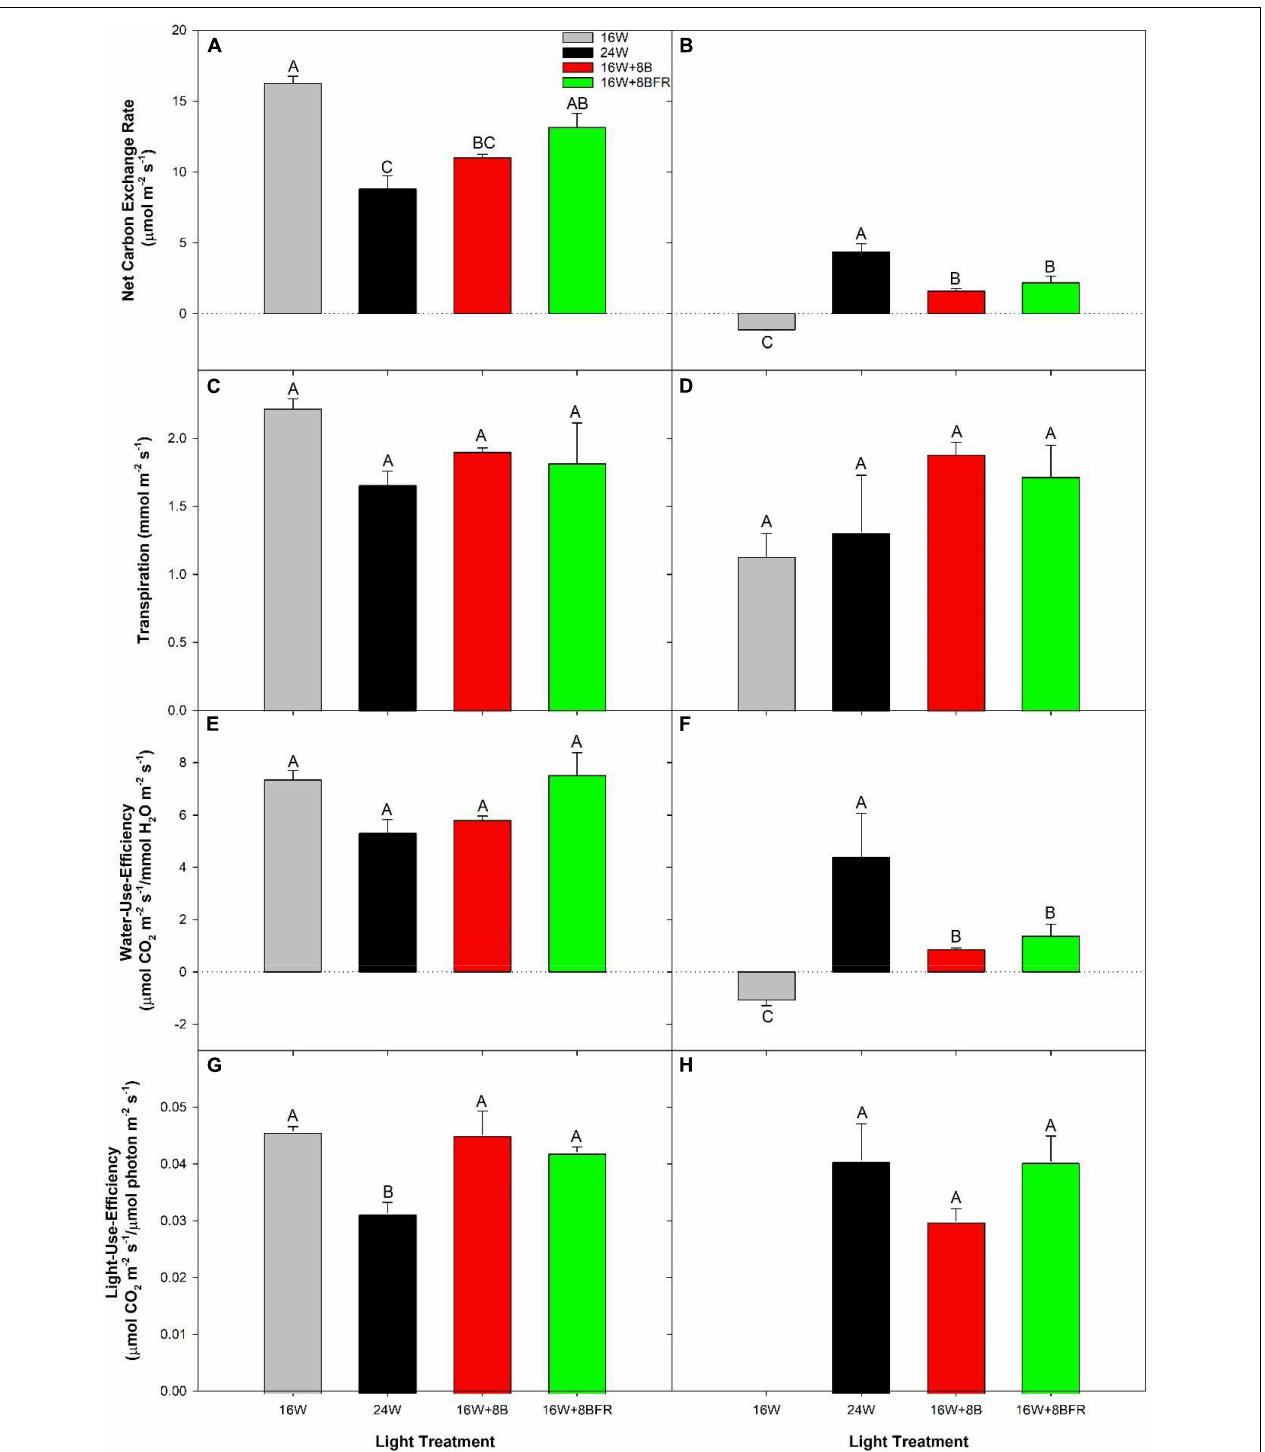
FIGURE 3 | Net carbon exchange rates (A,B) , transpiration rates (C,D) , water-use-efficiency (WUE; E,F ), and light-use-efficiency (LUE; G,H ) of the fifth leaf from pepper plants grown under the lighting treatments at 99 DIT during the daytime (A,C,E,G) and nighttime (B,D,F,H) . Daytime measurements were performed using a Li-COR 6400 fitted with a clear top chamber on a cloudy day and thus represent the photosynthesis driven mostly by the supplemental lighting. Nighttime measurements were performed after 22:30 (half an hour after night lighting started), allowing leaves to adjust to the new light environmental conditions. Error bars represent the standard errors of the means of n = 4. Letter groups (A, B, C) represent a significant difference within a panel between the lighting treatments ( p < 0.05).